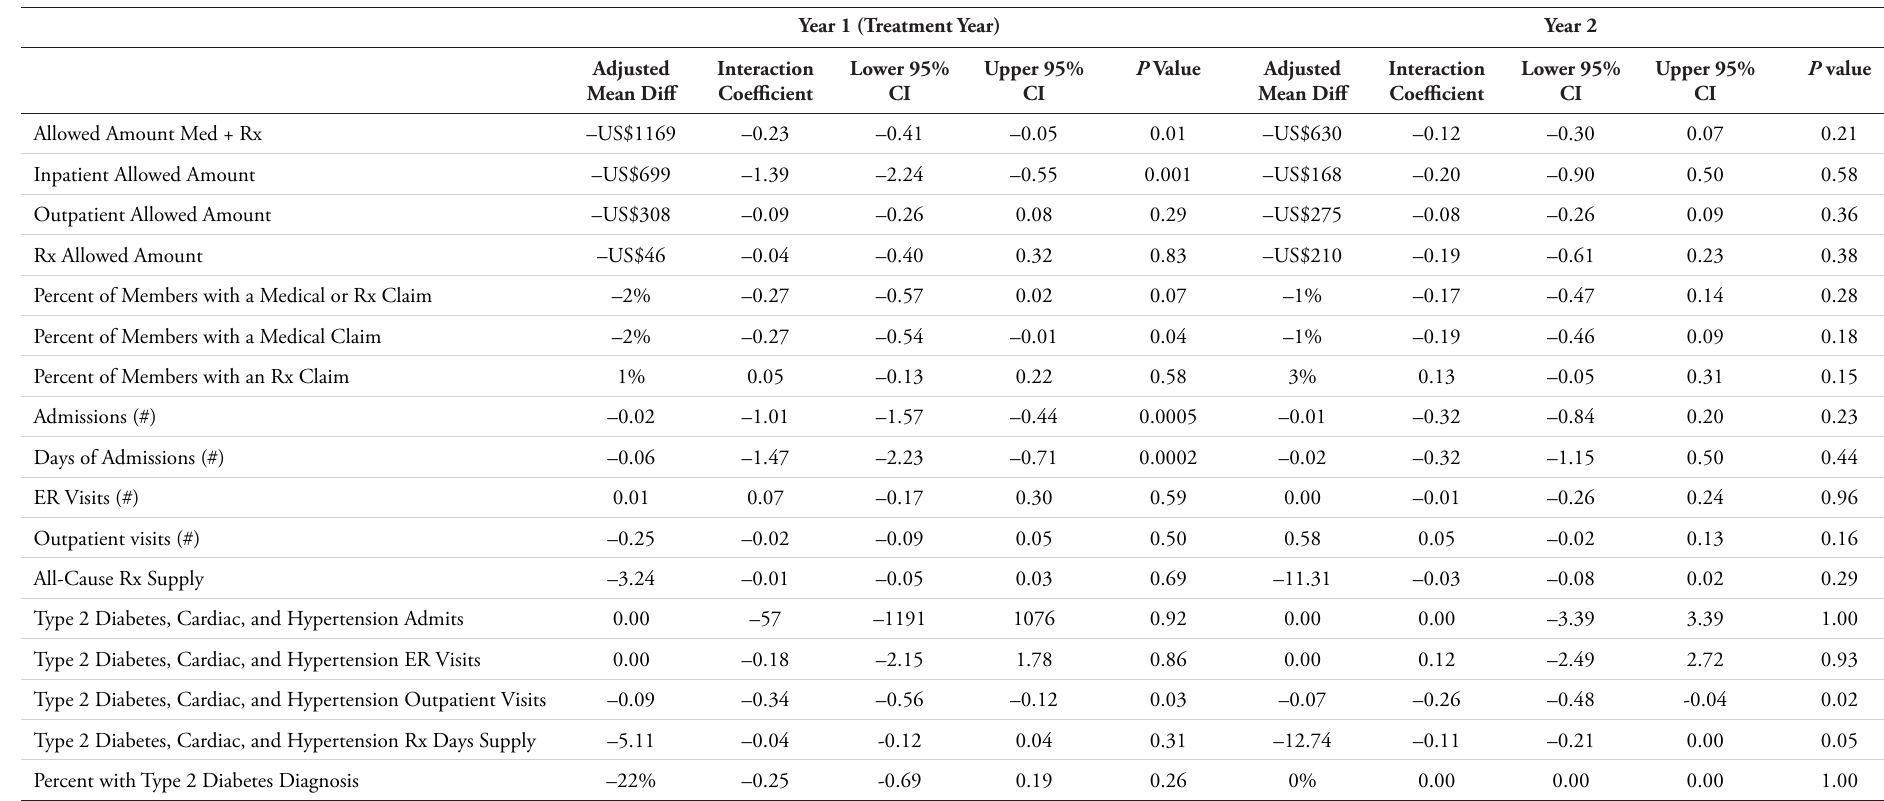
Table 3. Differences-in-Differences Outcomes of Health care Costs and Utilization Between DPP Participants (n = 2027) and Matched Comparisons (n =